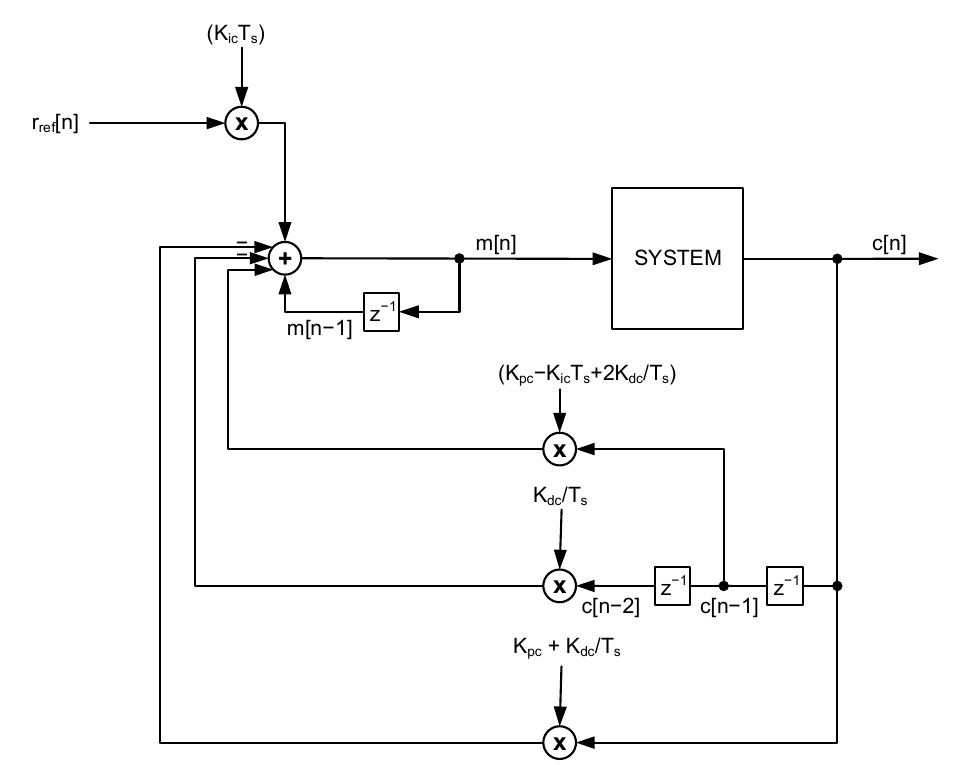
Figure 13. Block diagram of velocity form implementation of PID.